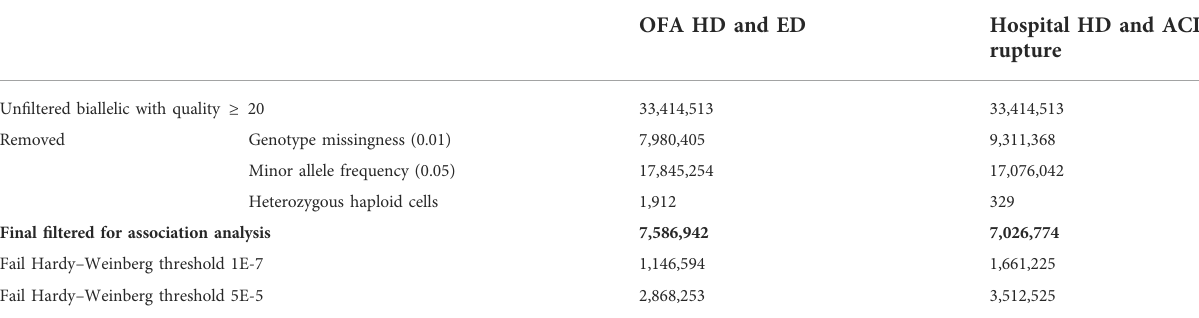
TABLE 2 Detailed reporting of SNP fi